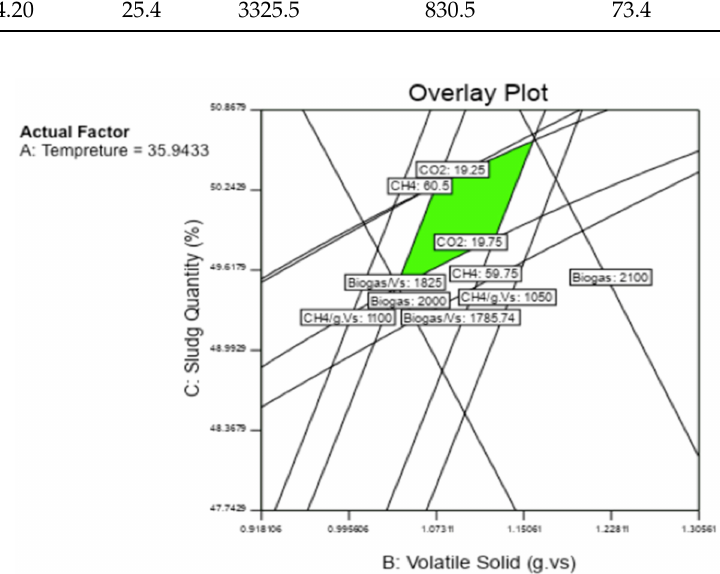
Figure 43. Overlay plot based on the first criterion for date